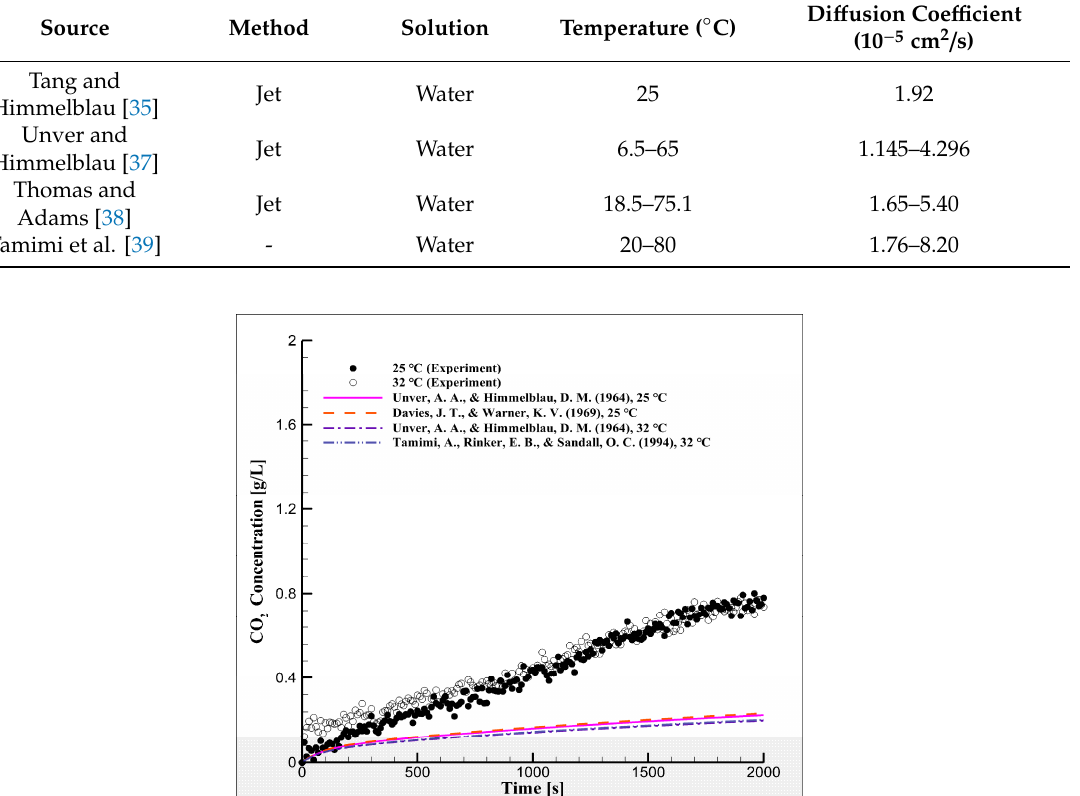
Figure 2. Long-term CO 2 concentration over time due to equilibrium pressure and temperature in distilled water. distilled